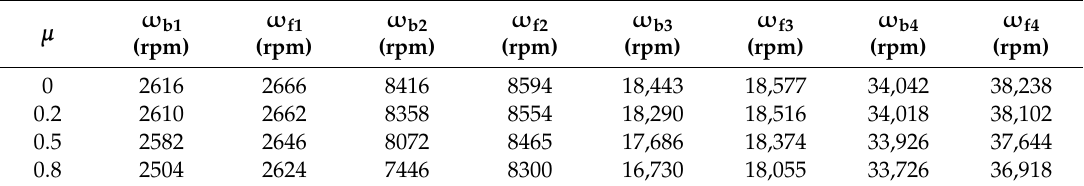
Table 5. First four forwards and backwards critical whirl